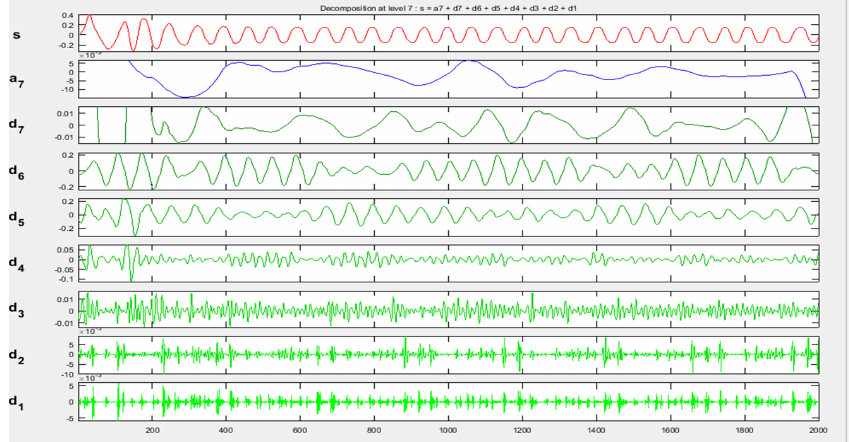
Figure 7. Representation of DWT approximation coefficients and detail coefficients of HCR fault in Phase-A currents with 2000 samples. Energies 2022 , 15 , x FOR PEER REVIEW